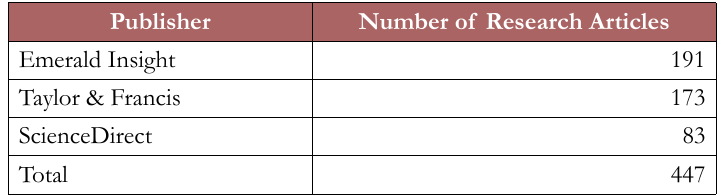
Table 2. Research articles details by publisher